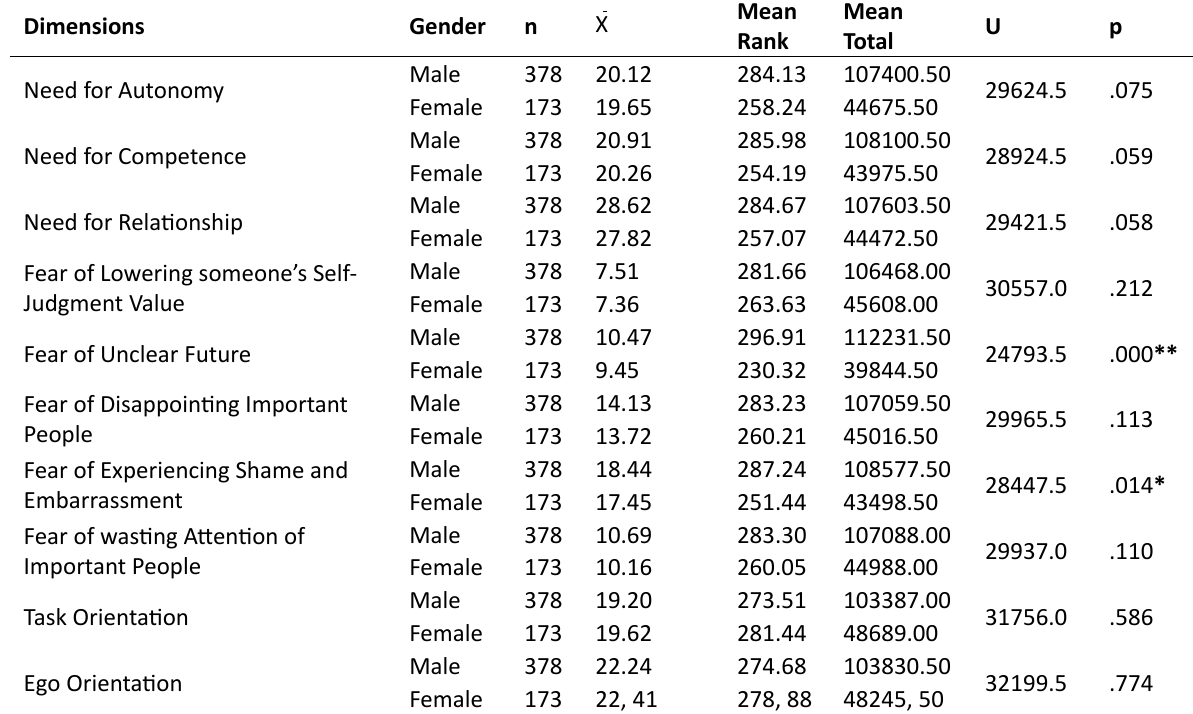
Table 1. Evaluation of the grades of the participants’ basic psychological needs, performance failure appraisal and task and ego orientation in sport according to gender variable